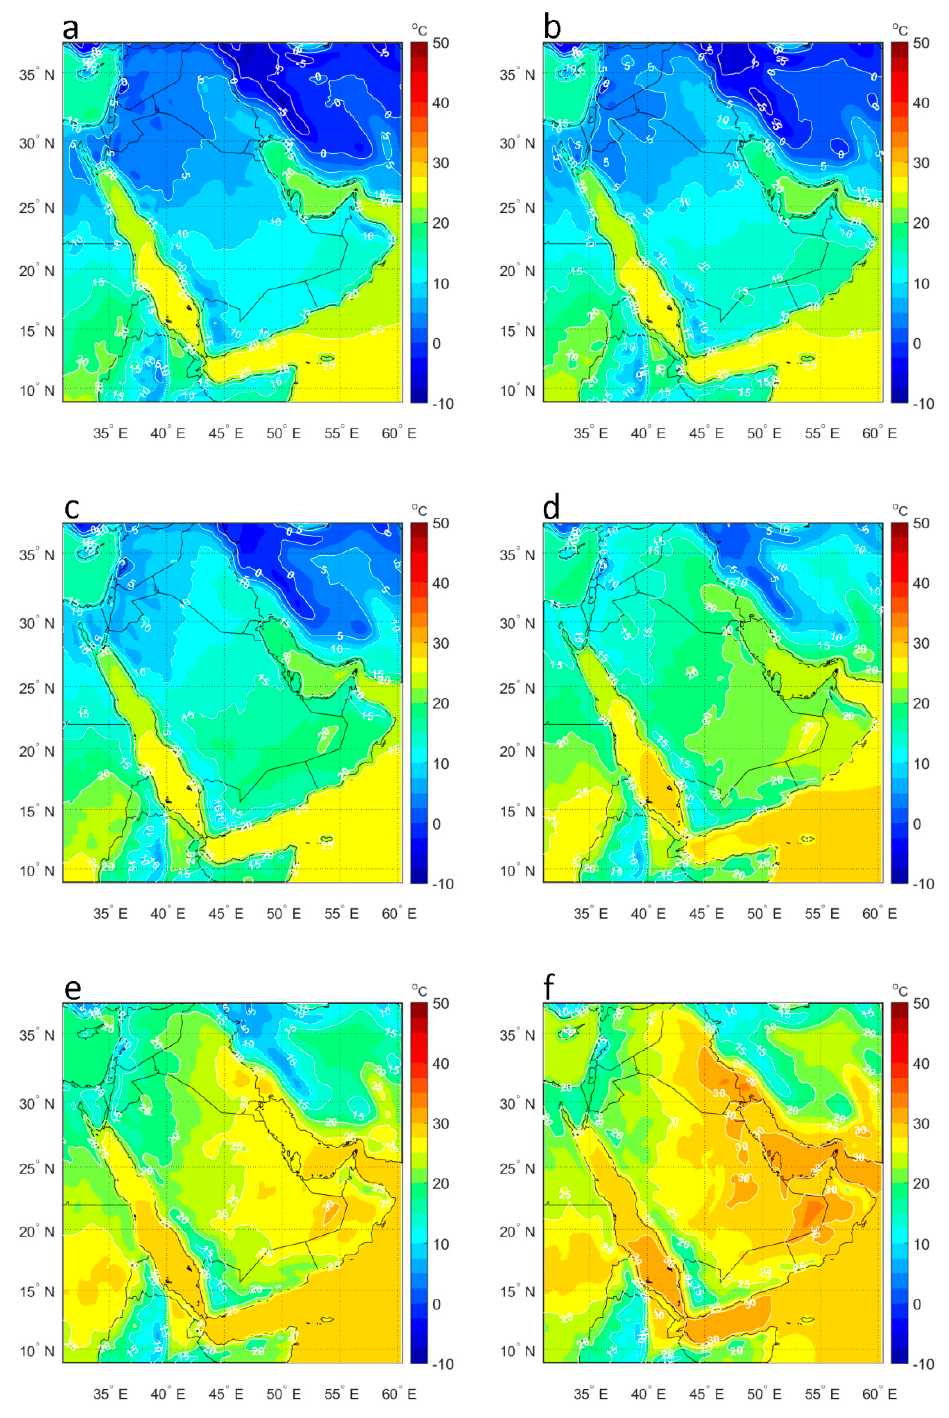
Figure A5. Mean values of daily minimum temperature for the months January to June ( a – f ).